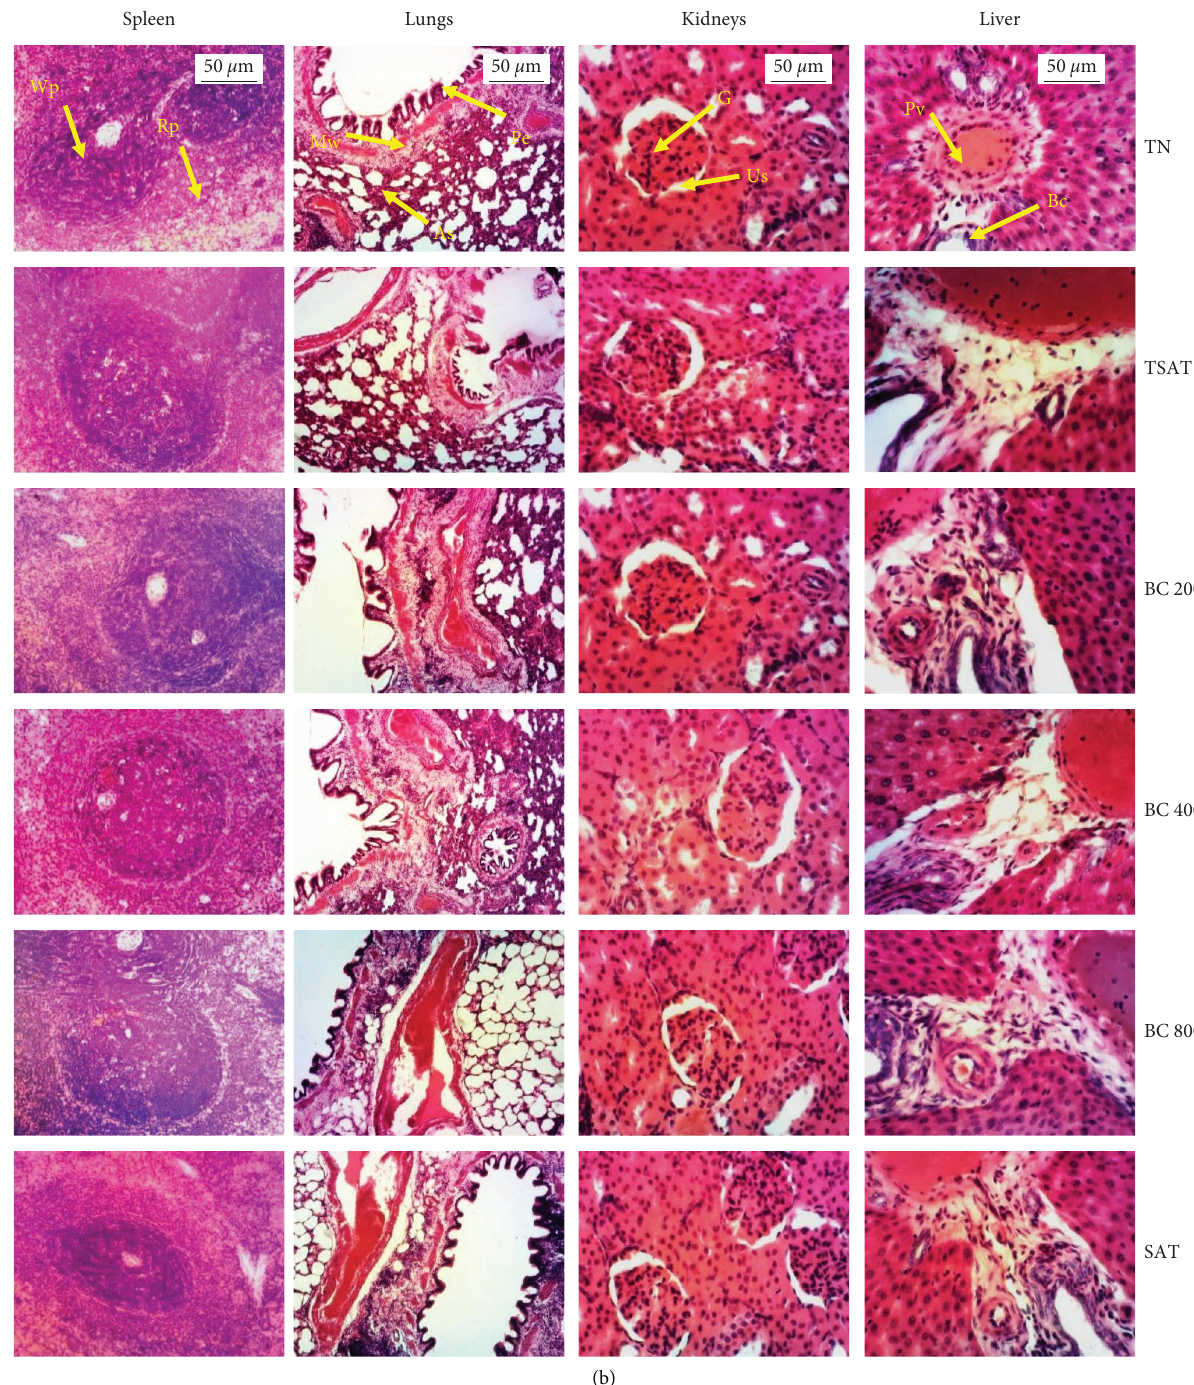
Figure 3: Efects of the plant mixture aqueous extract on the microarchitecture of the liver, kidneys, spleen, and lungs in female (a) and male (b)